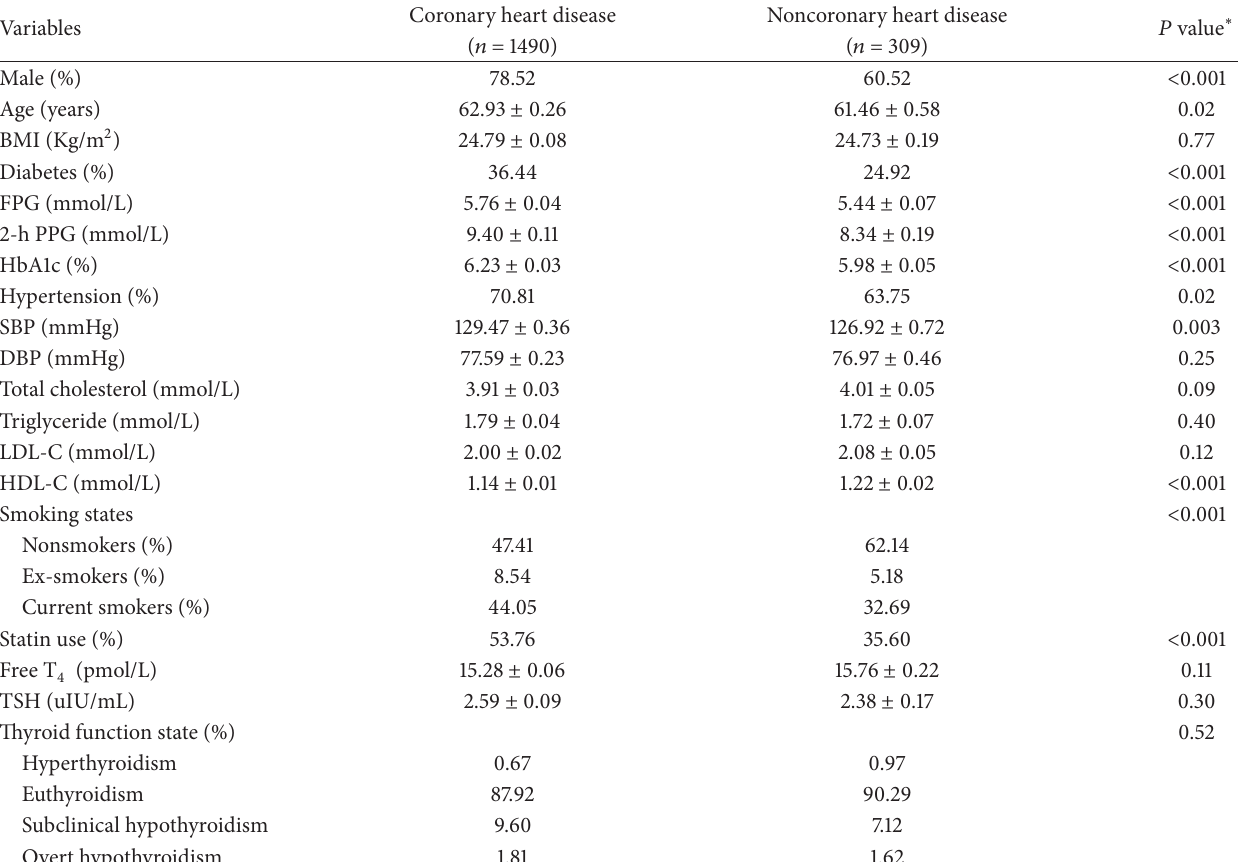
Table 1: Characteristics of the study population by coronary heart disease and noncoronary heart